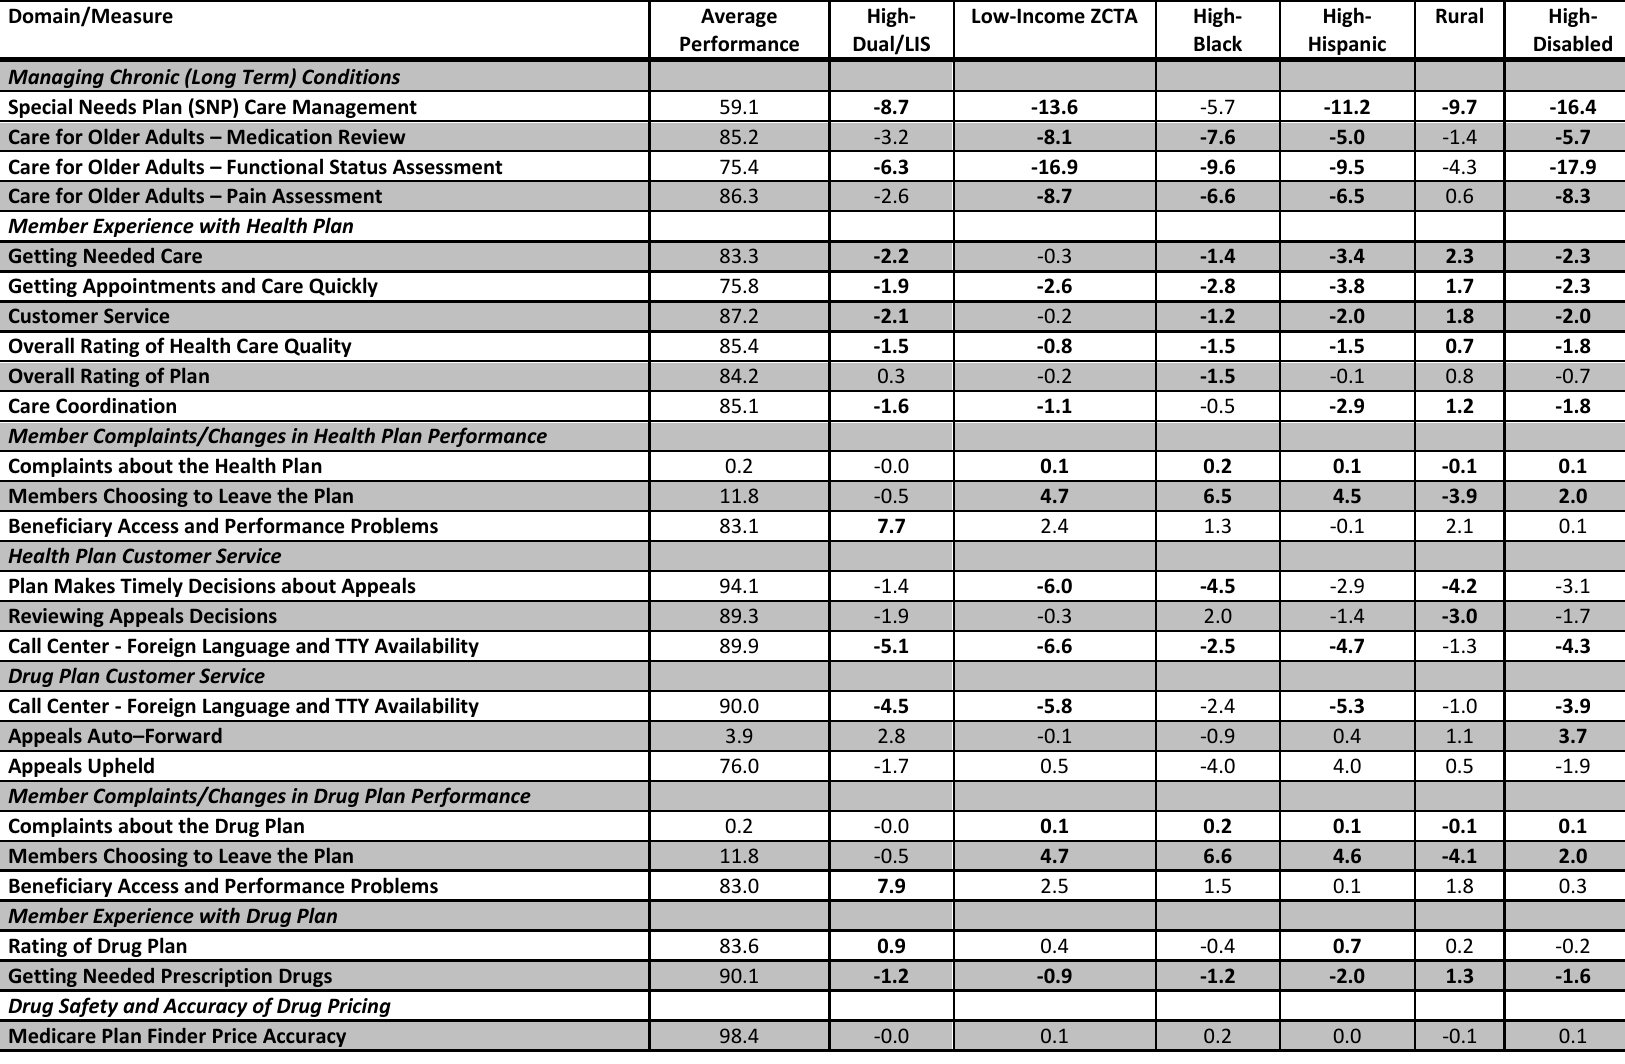
Table 8.5: Contract Social Risk and MA Contract-Level Measure Performance, Difference in Rates of Achieving Measure, 2014